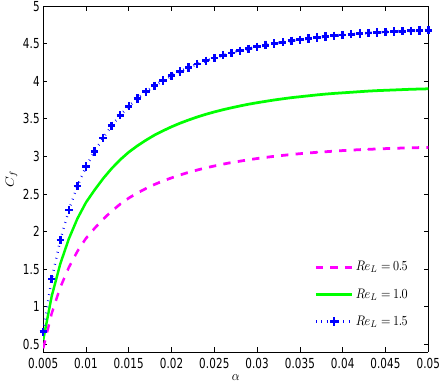
Fig. 13: Variation of C f with α for β = 0.005 .